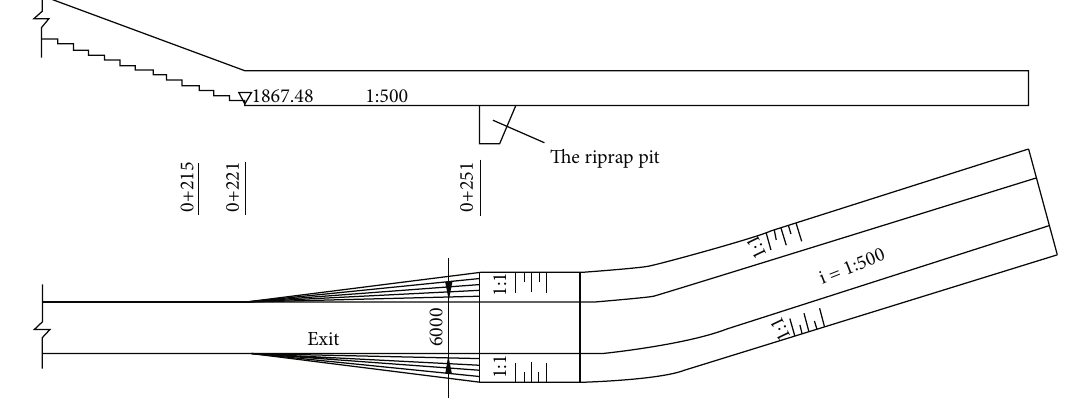
Figure 1: The section layout of spillway. Table 1: Hydraulic parameter similarity under the condition of gravity similarity.